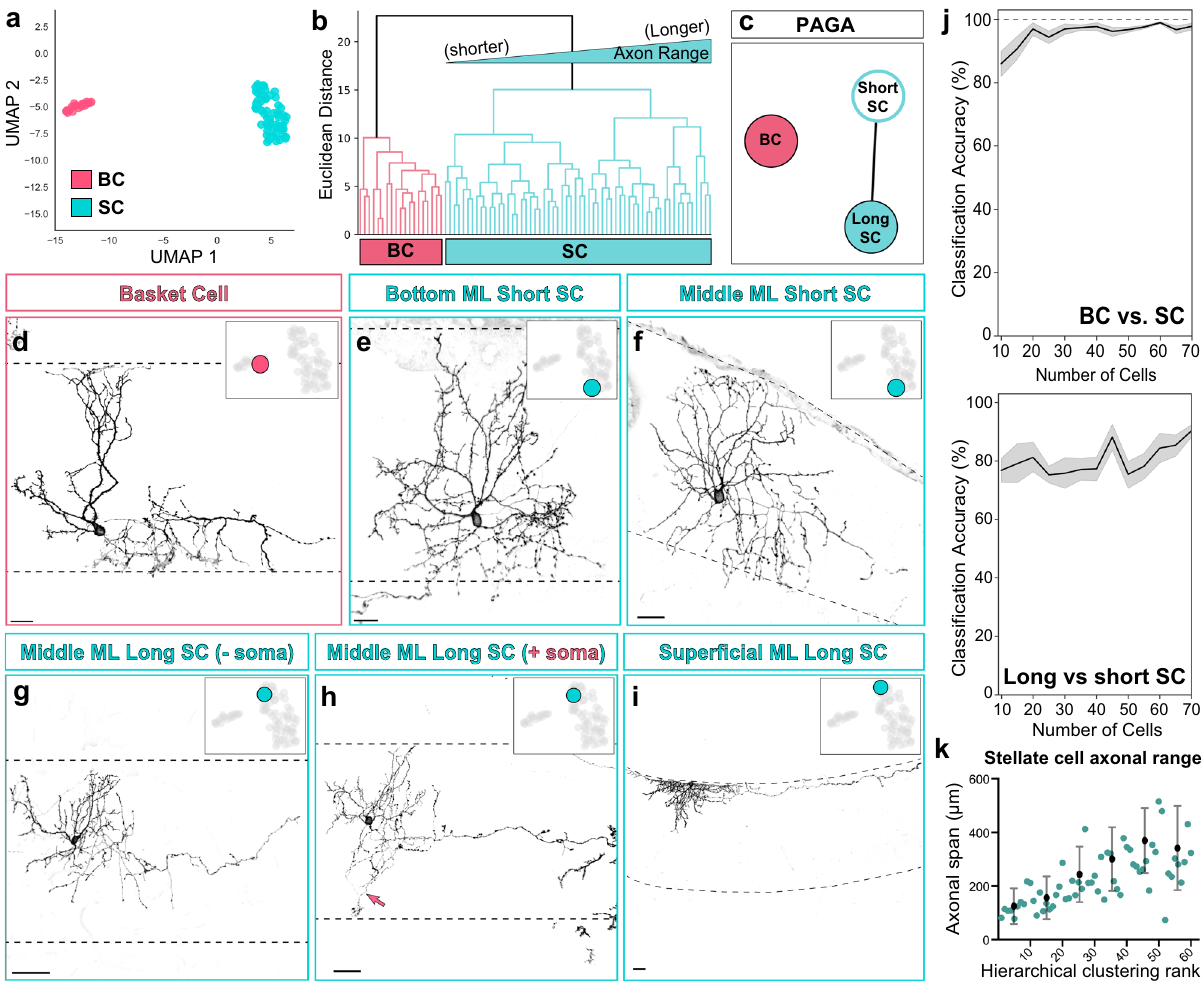
Fig. 2 Clustering of mature MLI morphologies reveals discrete and continuous heterogeneity. a UMAP plot separates 79 mature MLI morphological reconstructions into discrete basket (BC, pink) and stellate cell (SC, teal) clusters. Each data point represents a single MLI based on morphometric measurements. b Hierarchical clustering separates MLIs into two BC (pink) and SC (teal) clades. Within the broad SC cluster, the dendrogram ordered MLIs from shorter to longer axonal range cells. c PAGA separates MLIs into discrete BC and SC clusters. SCs are subdivided into two nodes connected through an edge, denoting continuous variation in morphology. d – i Examples of MLIs and their locations within the UMAP manifold. ML boundaries are outlined by dashed lines. d MLI from the BC cluster displays canonical BC morphology. e An MLI at one pole of the SC cluster displays short-range axonal morphology and its soma resides within the lower ML. f An MLI plotted within similar coordinates of the UMAP manifold as e , displays short-range axonal morphology but resides within the middle ML. g An MLI at the opposite pole of the SC cluster displays long-range axonal morphology. h An MLI which resides within similar coordinates of the UMAP as g , extends descending PC soma-targeting axon collaterals (pink arrow at PC soma; axon terminal reaches the PC soma base). i An MLI located in the very super fi cial ML extends long axonal range collaterals. j Iterative clustering using random subsamples shows that MLI classi fi cation into BC/SC clades is robust, as cross-validation using as few as 20 subsampled cells replicates the BC/SC division. By similar measures, classi fi cation of SCs into long- and short-range subclades is not robust. Lines show means drawn from 20 trials for each sample size, with SEM represented by shaded regions. k Axonal span of SCs vary continuously from shorter-range to longer-range cells, ranked by hierarchical clustering rank. Error bars represent mean and SD of the data, n = 61 SCs in UMAP, 60 in hierarchical clustering; 18 BCs in UMAP, 19 in hierarchical clustering. Scale bars are 20 µ m in d – f , 40 µ m in g – i